Question: Identify the chart type used in this figure.
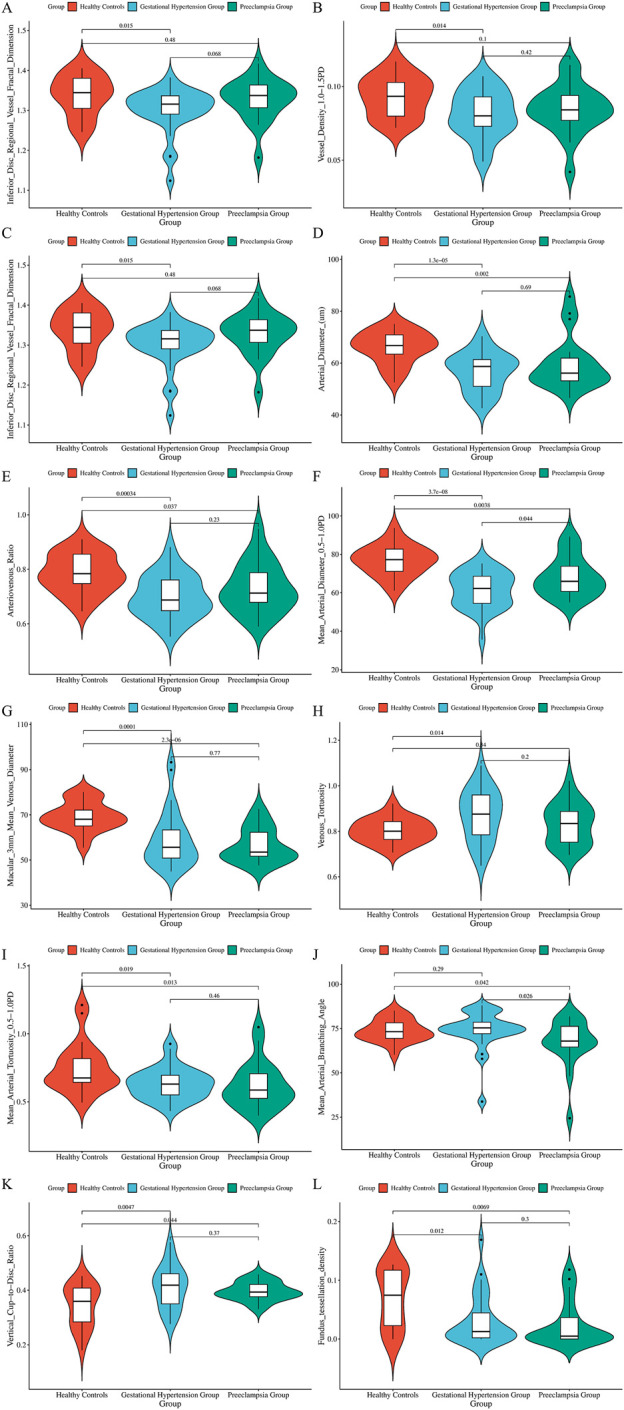
Answer: box